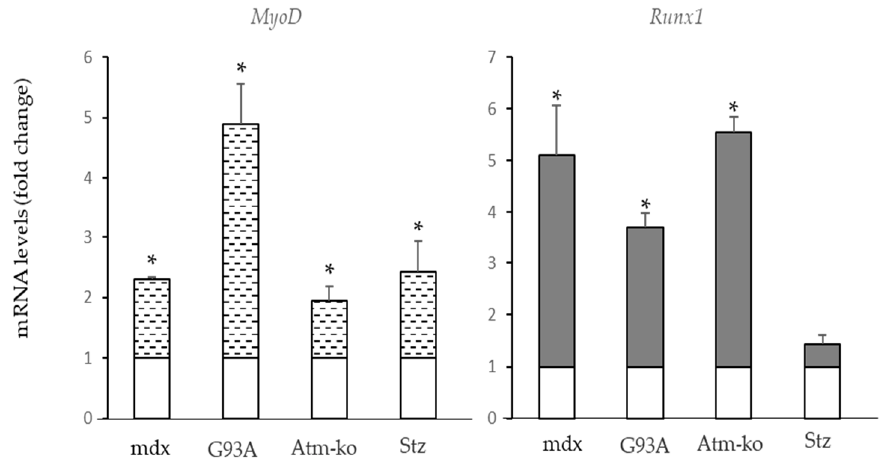
Figure 5. MyoD and Runx1 mRNA levels in skeletal muscle under pathophysiological conditions. The mRNA levels of MyoD and Runx1 were measured by RT-qPCR. mRNA levels in the samples (dotted or grey columns) are expressed as the fold change compared with the samples from muscle from wild-type mice (empty columns). All values represent the mean ± SD of n = 3 different RNA preparations. * Indicates statistical significance of pathological samples compared with control samples ( t -test: p < 0.05).